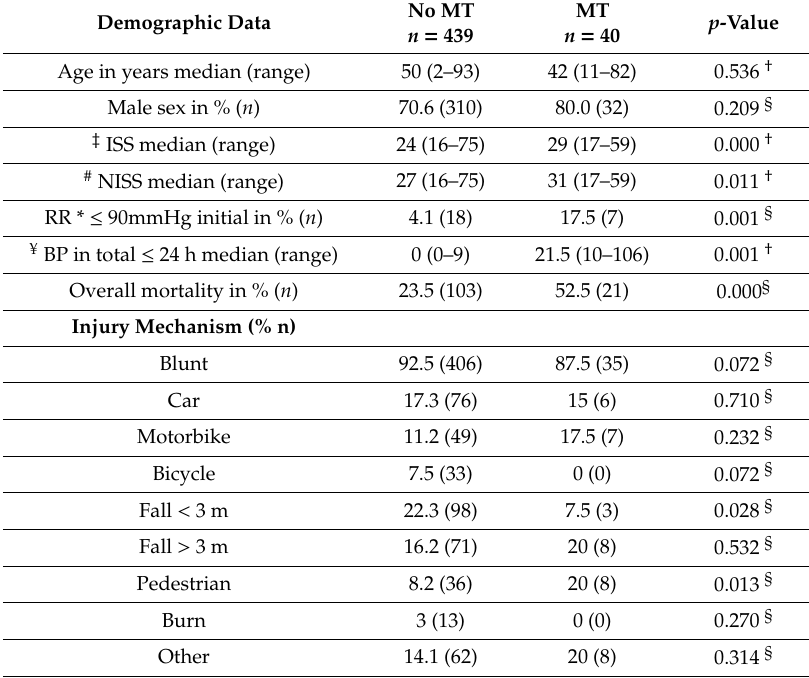
Table 2. Demographic data, injury mechanisms, and trauma